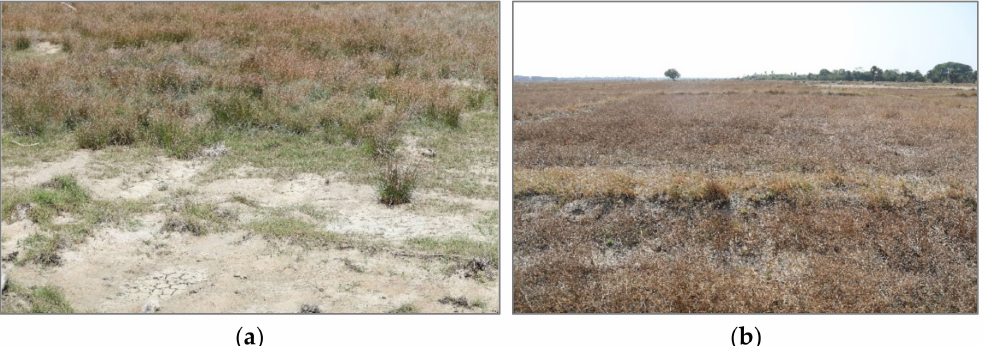
Figure 1. ( a ) Abandoned paddy lands in Jaffna Peninsula. ( b ) Whitish salt crust on the surfaces of paddy lands affected by salinity. The salt crust causes burning and death of rice